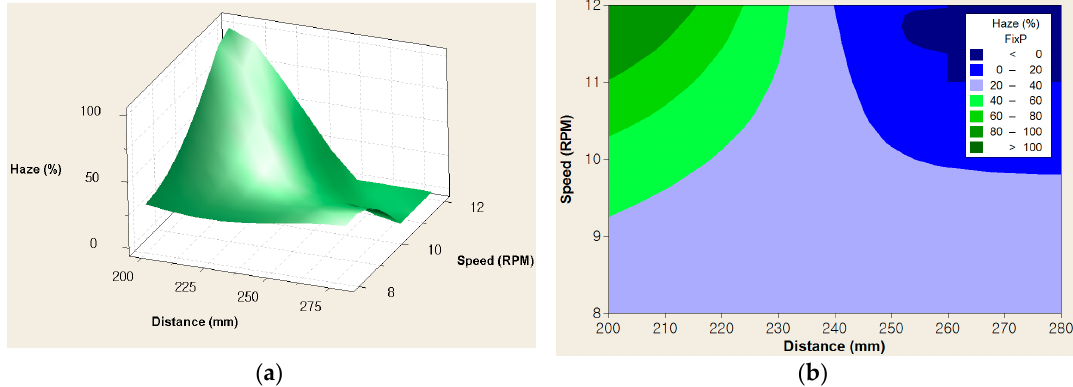
Figure 5. Effects of the motor speed for control of glass feed speed and the distance of the nozzle from the surface on the haze: ( a ) 3D surface plot; ( b ) contour plot.